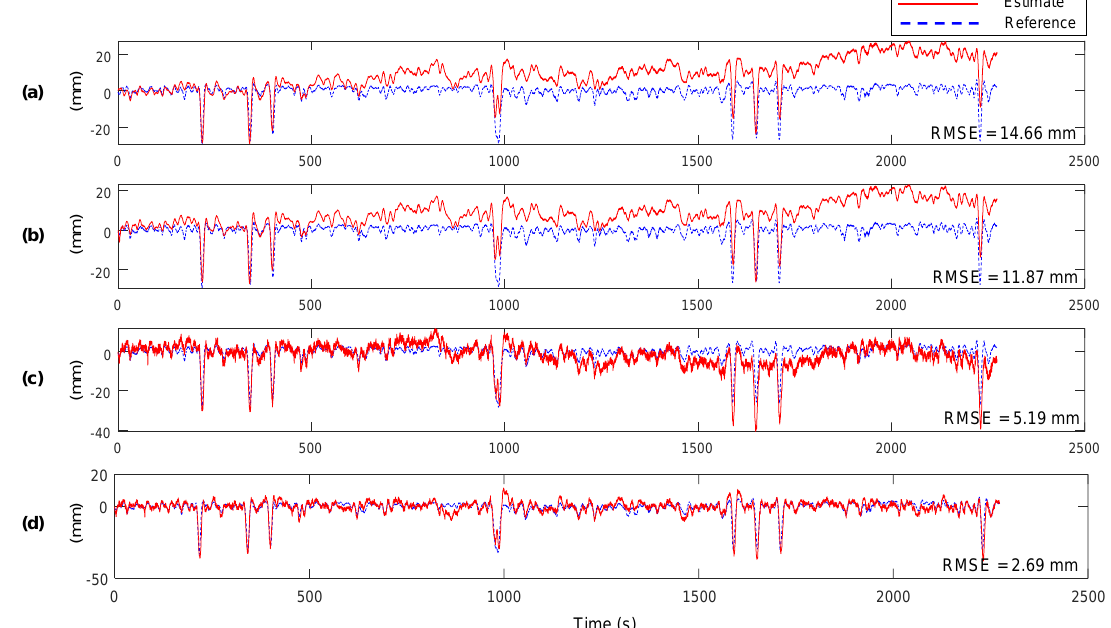
Figure 12. Displacement estimation results and RMSE errors for the Yeongjong Grand bridge: ( a ) the method proposed by Smyth and Wu [23], ( b ) tightly-coupled and ( c ) loosely-coupled Kalman filter [22], and ( d ) the proposed method.